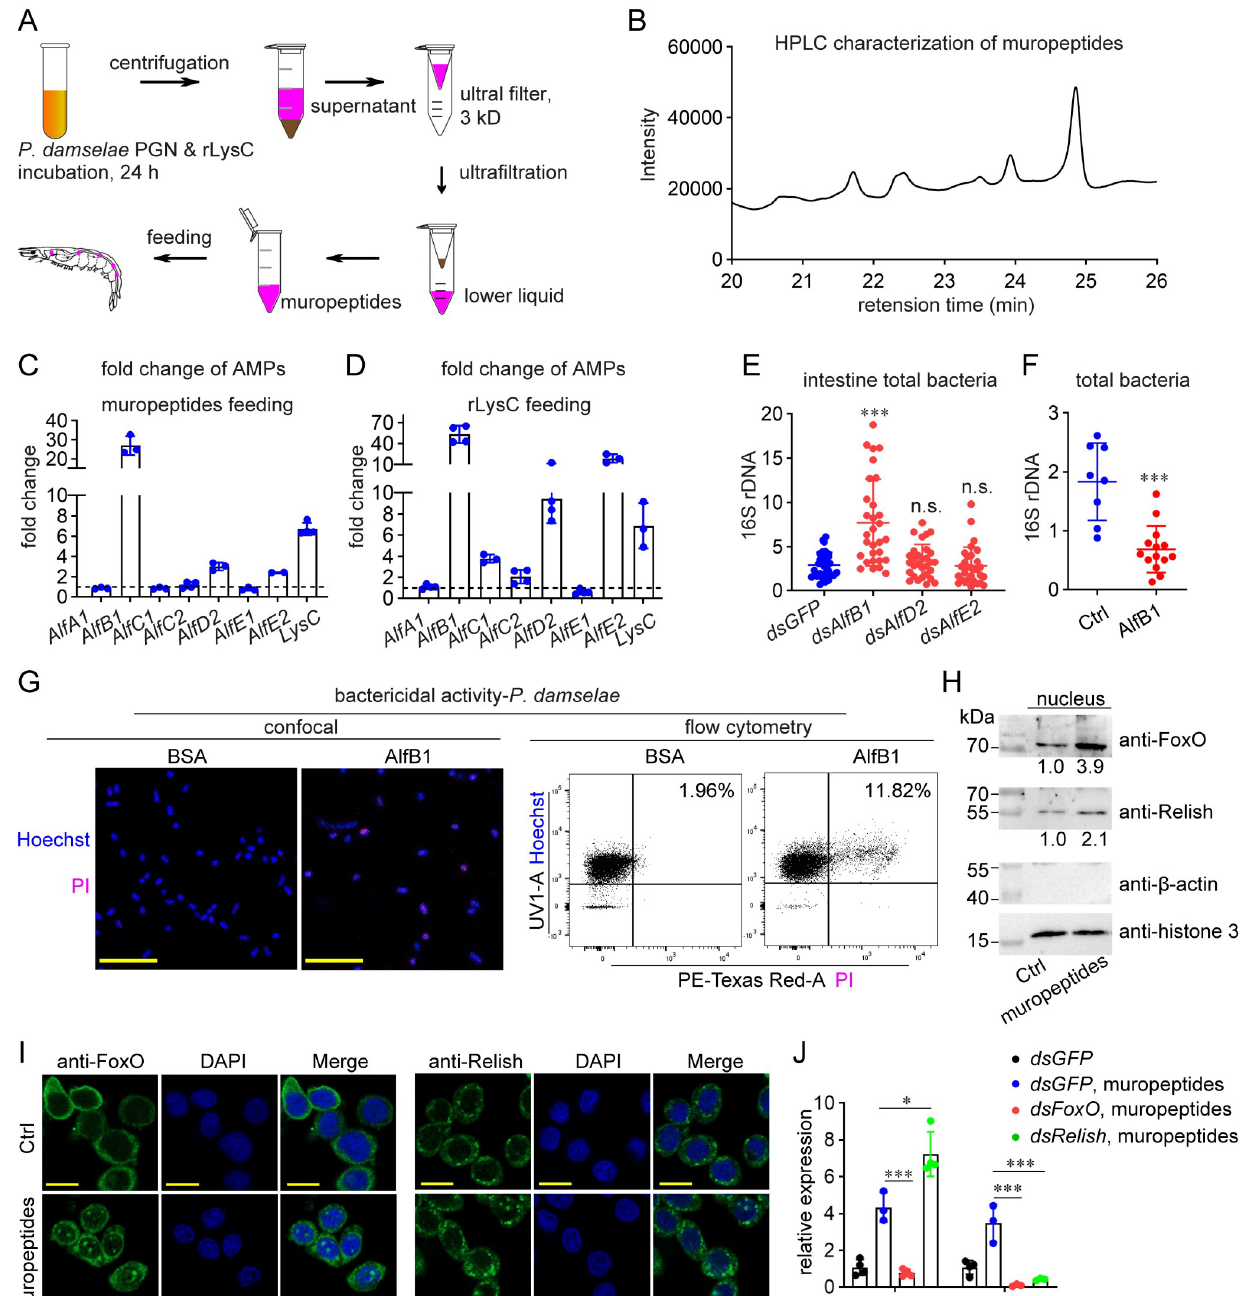
Fig 3. Immunomodulatory role of LysC in intestinal immunity. (A) Schematic illustration of the generation of muropeptides. (B) HPLC characterization of LysC-generated muropeptides. Muropeptide solution (20 μ l) was characterized by the reversed-phase column. UV detection was performed at 206 nm. (C) Induction of AMPs by oral treatment with muropeptides. Muropeptides (10 μ g) were introduced into intestines. qRT-PCR was performed to detect gene expression 6 h later. (D) Induction of AMPs by feeding with rLysC. rLysC (5 μ g) was introduced into intestines, AMPs expression was detected 12 h later. (E) Influence of the abundance of intestinal total bacteria by knockdown of three Alfs . The bacterial abundance was determined by detecting 16S rDNA using qPCR 4 d after RNAi. (F) Influence of the abundance of intestinal total bacteria by AlfB1 oral treatment. AlfB1 (2 μ g) was administered into intestines, the bacterial abundance was detected 1 d later. (G) Bactericidal activity of AlfB1, revealed by PI staining. P . damselae were treated with 5 μ M of AlfB1 for 2 h at 28˚C, and labeled with Hoechst (staining all cells) and PI (staining dead cells). The cells were observed under a confocal microscopy or analyzed using flow cytometry. Scale bar = 10 μ m. Flow cytometry collected 10,000 events. Statistical analysis was performed by calculating Q2/(Q1+Q2) × 100%. (H) Induction of the nucleus level of FoxO and Relish by muropeptides, revealed by western blotting.